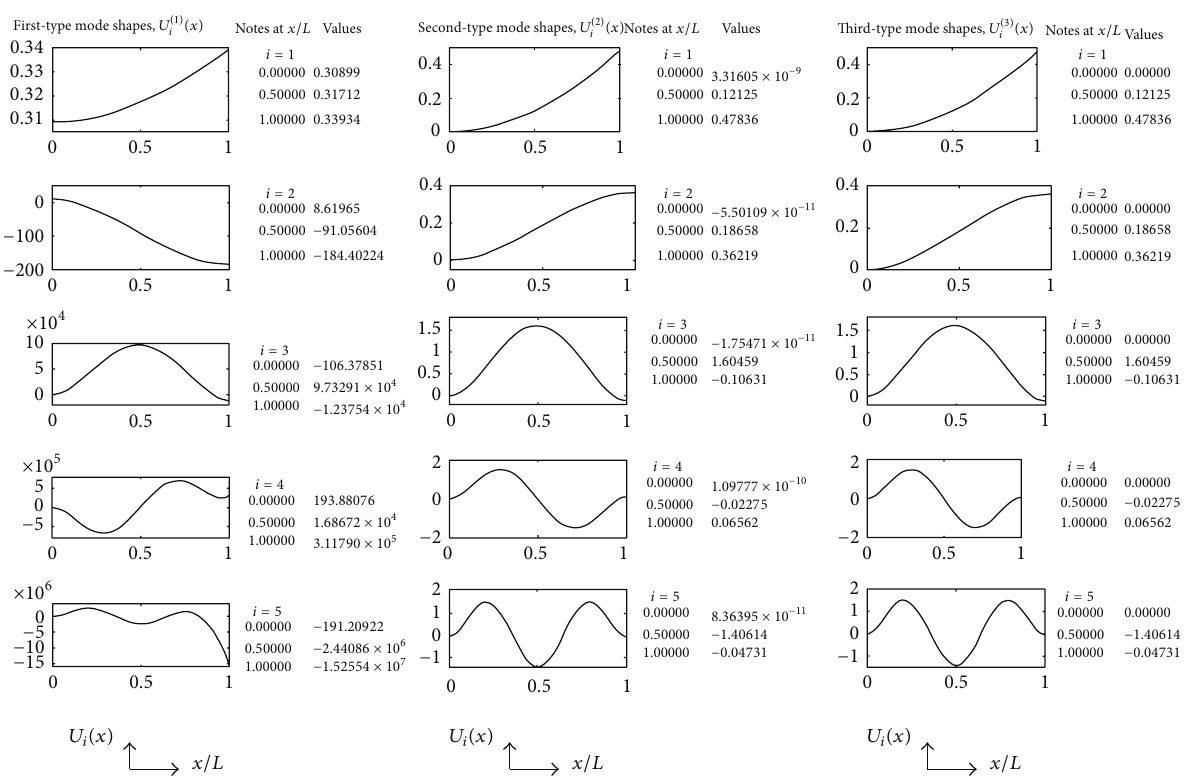
Figure 6: Three types of the first five mode shapes with the combinations of 𝜙 = 4 , 𝑘/𝐿 = 4 , and 𝑑/𝐿 = 1